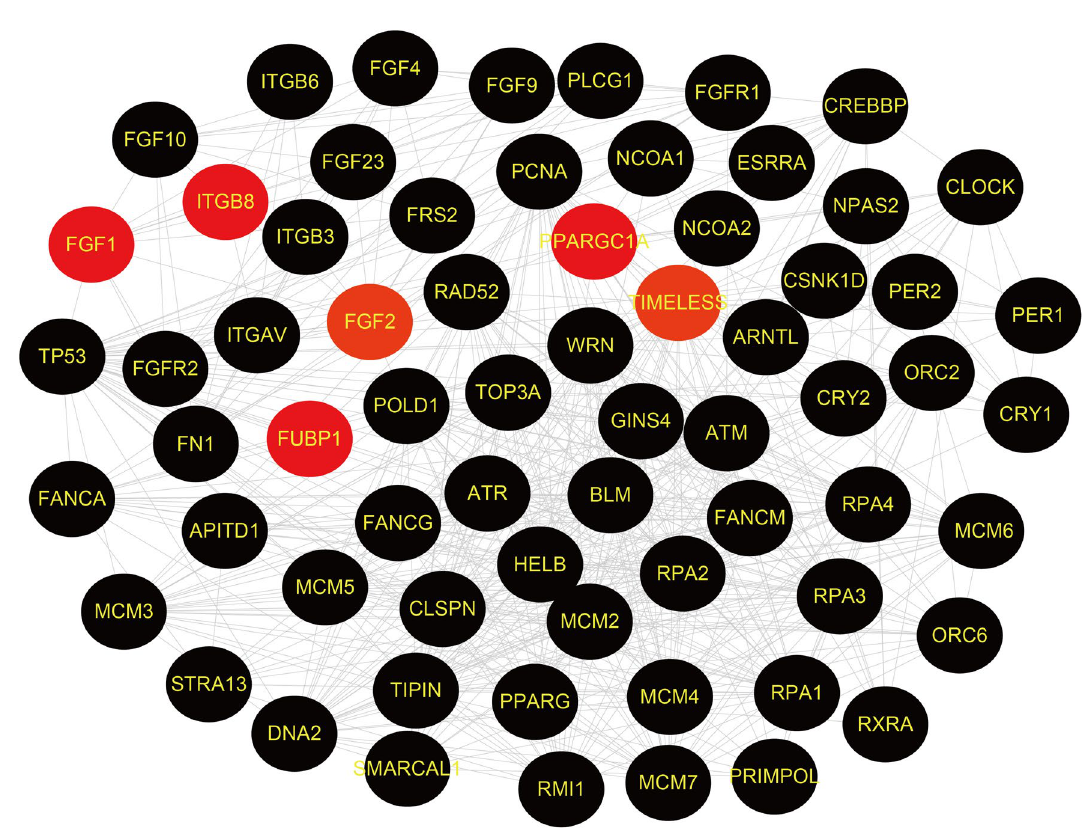
Figure 4. Protein–protein interaction (PPI) networks for identified common DEGs. Red colored nodes indicate common DEGs, which are the functional genes during enrichment. Black colored nodes represent the genes interacting with DEGs predicted through STIRNG website. The edge between the two nodes represents the interaction between the